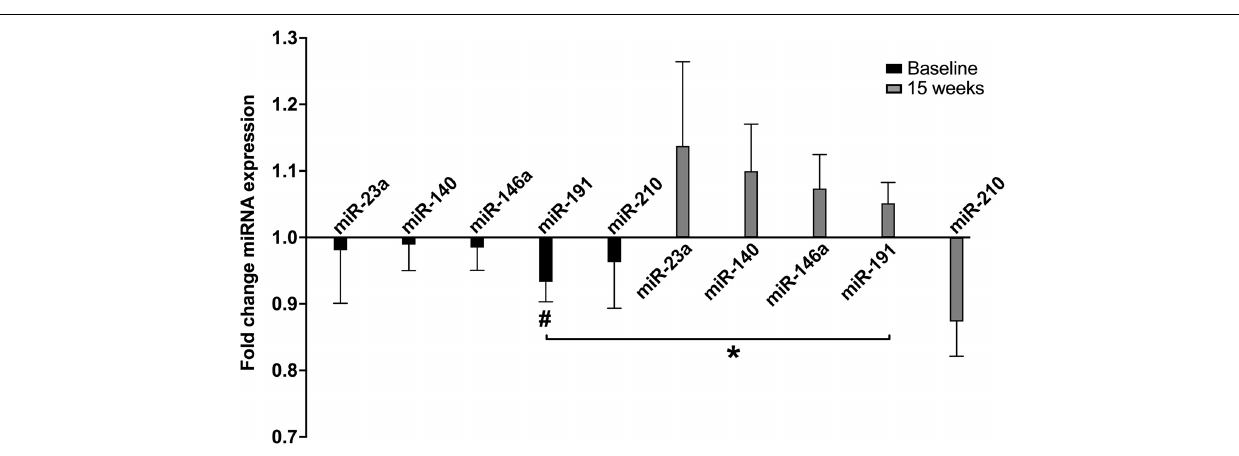
FIGURE 3 | Fold change miRNA expression with acute exercise at baseline and after 15 weeks of exercise training in ET. ET, exercise training group ( n = 25); Fold change, post CPET/pre CPET miRNA expression. Data are expressed as mean and error. # within group p < 0.05, * p -value for interaction <